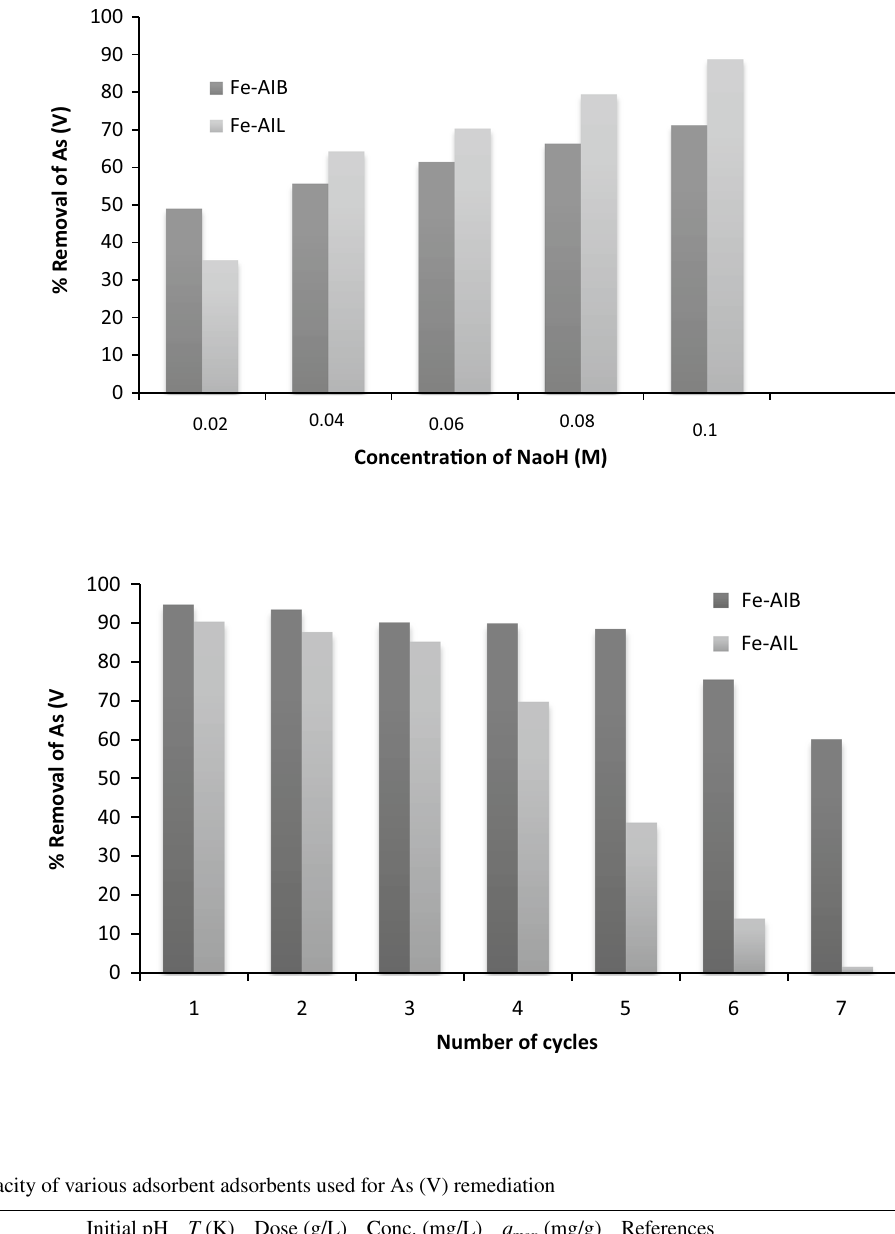
Fig. 16 desorption study on Fe-AIB and Fe-AIL by NaoH as desorbing agent